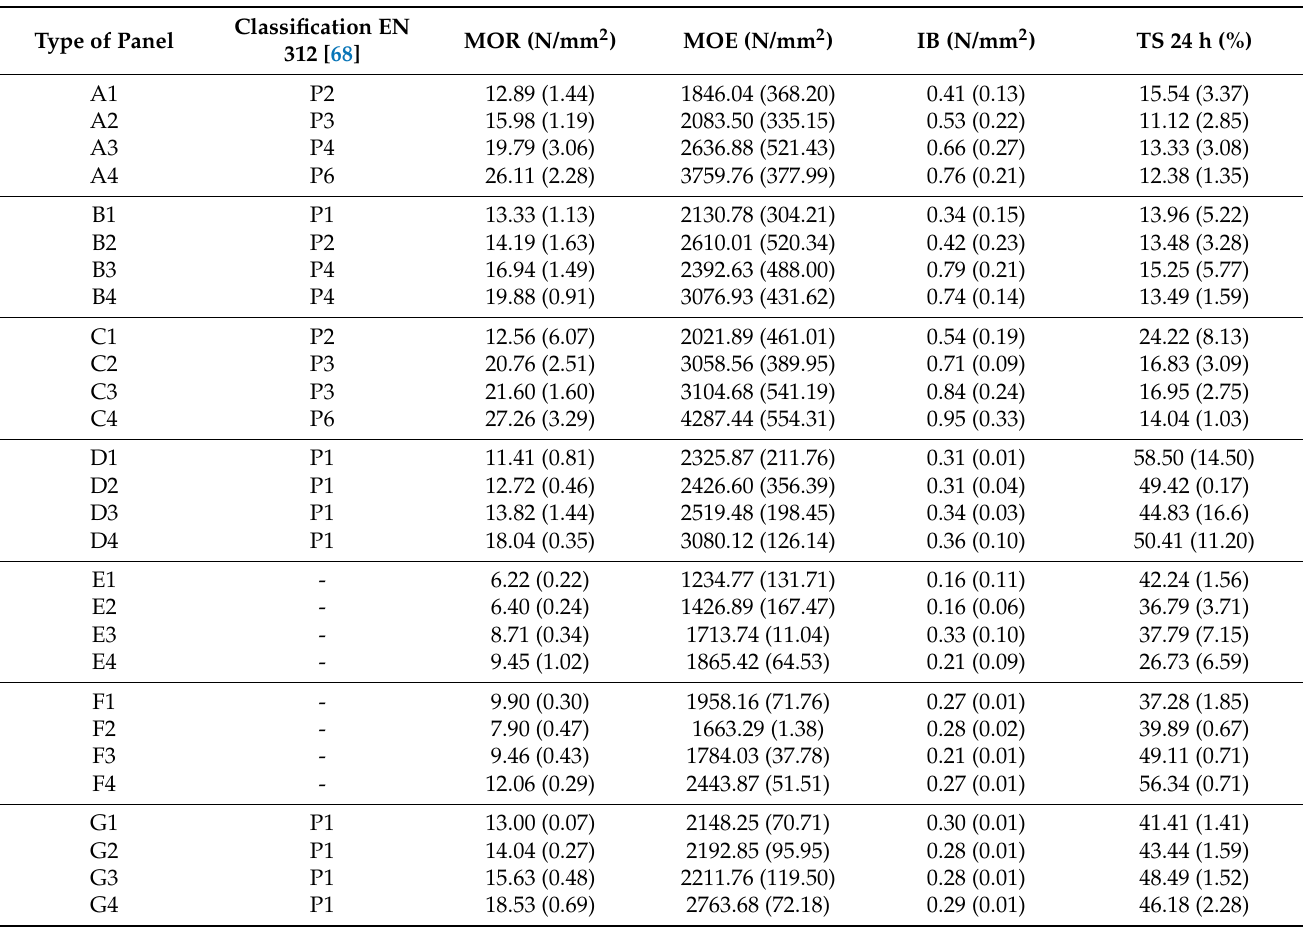
Table 6. Physical and mechanical properties of the experimental